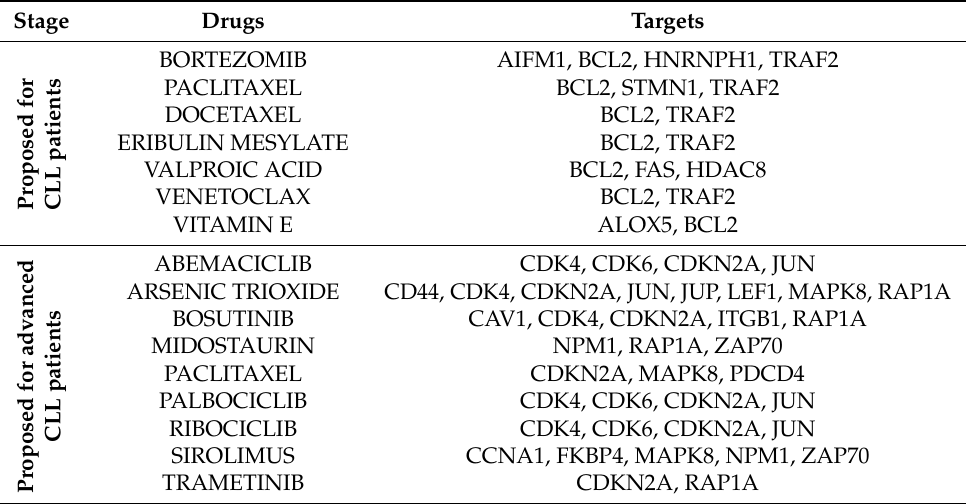
Table 2. Proposed repurposed drugs based on proteomics and drug repurposing data. Drug repurposing based on drug targets proposed by proteomics and drug repurposing drug targets using PanDrugs [146]. Only drugs with high scores are